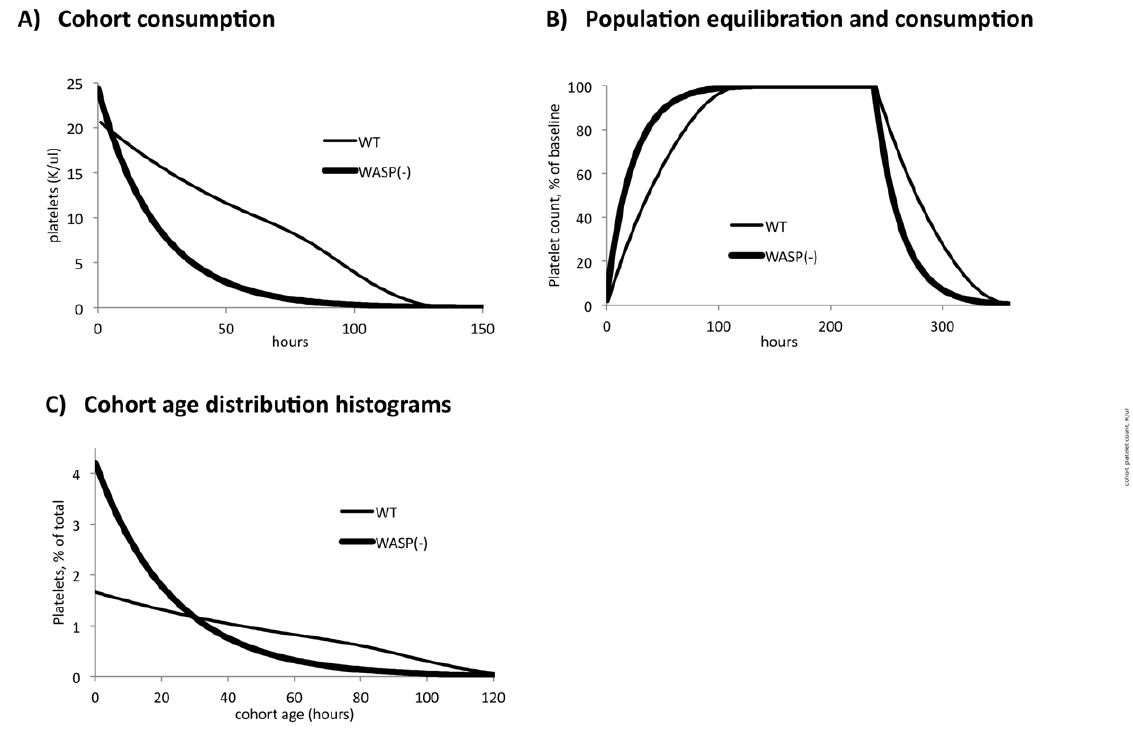
Figure 2. Model cohort and population platelet kinetics. A) The two model platelet cohorts shown were generated at 20.6 K/ul/hr (WT) and 24.3 K/ul/hr (WASP(-)), and consumed hourly at the following parameter values: WT, RD=1.16%/hr, SD=1.20, LS=105 hr; WASP(-), RD=4.21%/hr, SD=0.18, LS=150 hr. B) 240 sequential cohorts were generated hourly and consumed as in (A). Their summed hourly cohort values are shown. Note that production ceases after 240 hr. C) The platelet age distribution is taken from row the last row (time) of the equilibration phase (in this case, row i=240).